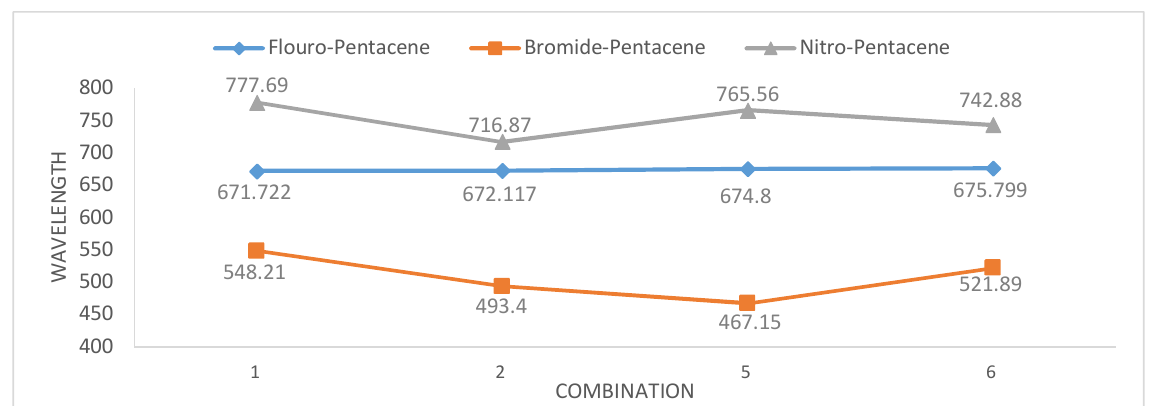
Fig. 6: Wavelengths (nm) of Flouro-Pentacene, Bromide-Pentacene, and Nitro-Pentacene Results at 1, 2,5 and 6